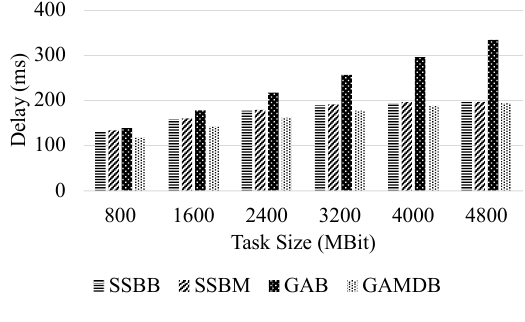
Figure 5. Total delay of the users.